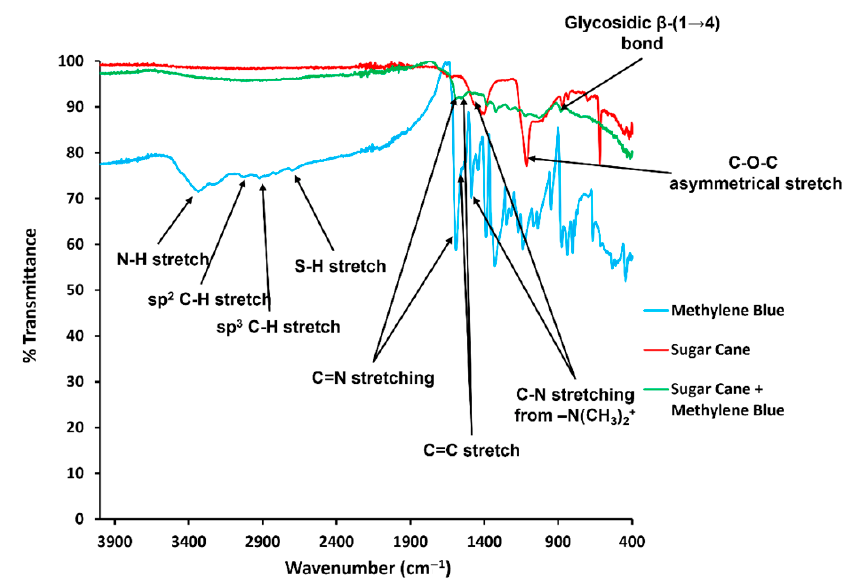
Figure 2. FT-IR spectra of MB (powder), SC, and the SC-MB hybrid nanocomposite.